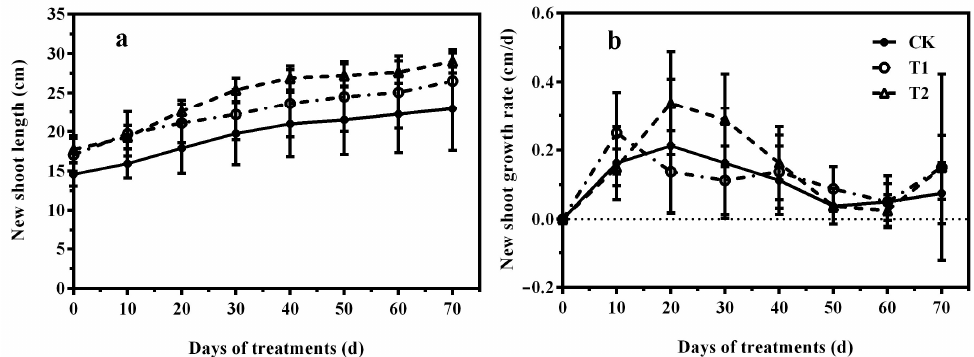
Figure 4. Dynamic changes of new shoot length and growth rate of ‘Misty’ grown in a plant factory with artificial lighting. Note: the bar indicates the standard